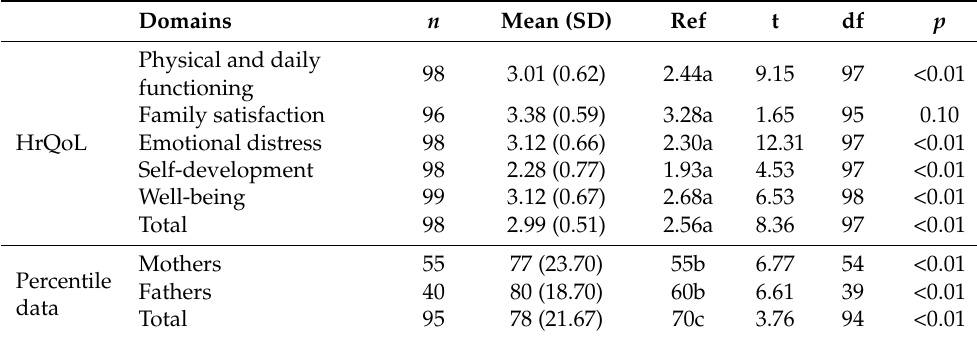
Table 4. HrQoL of parents (ULQIE)—Comparison with Reference Data.